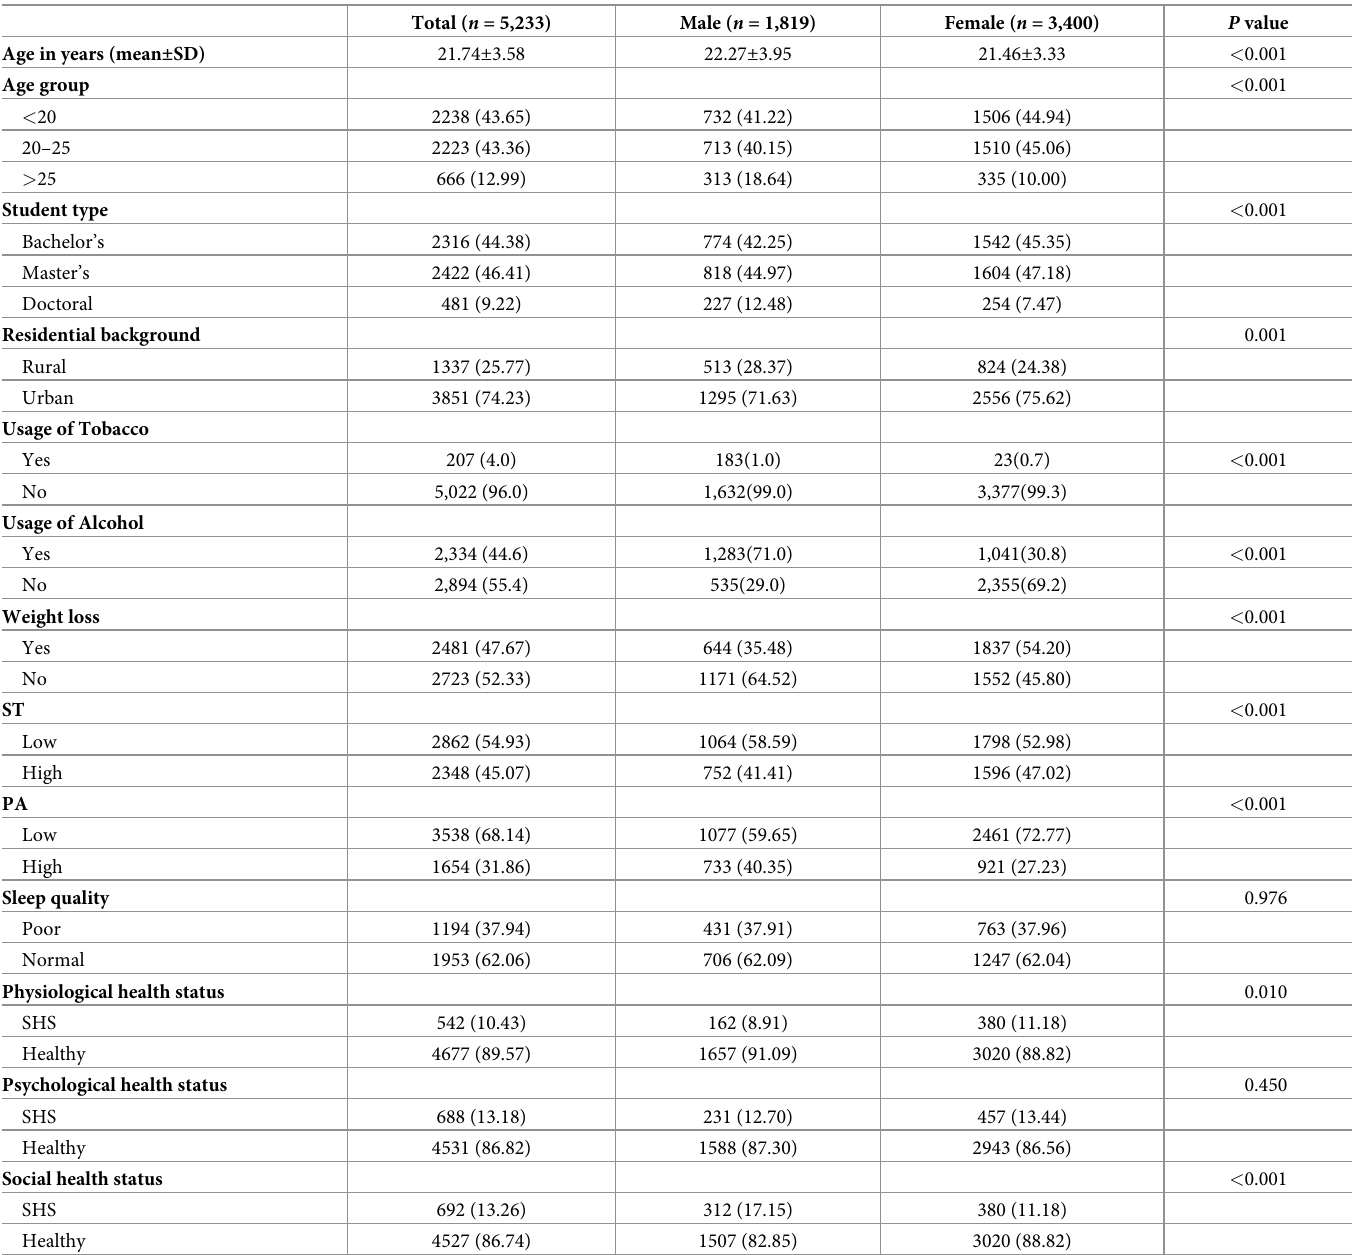
Table 1. Characteristics of surveyed